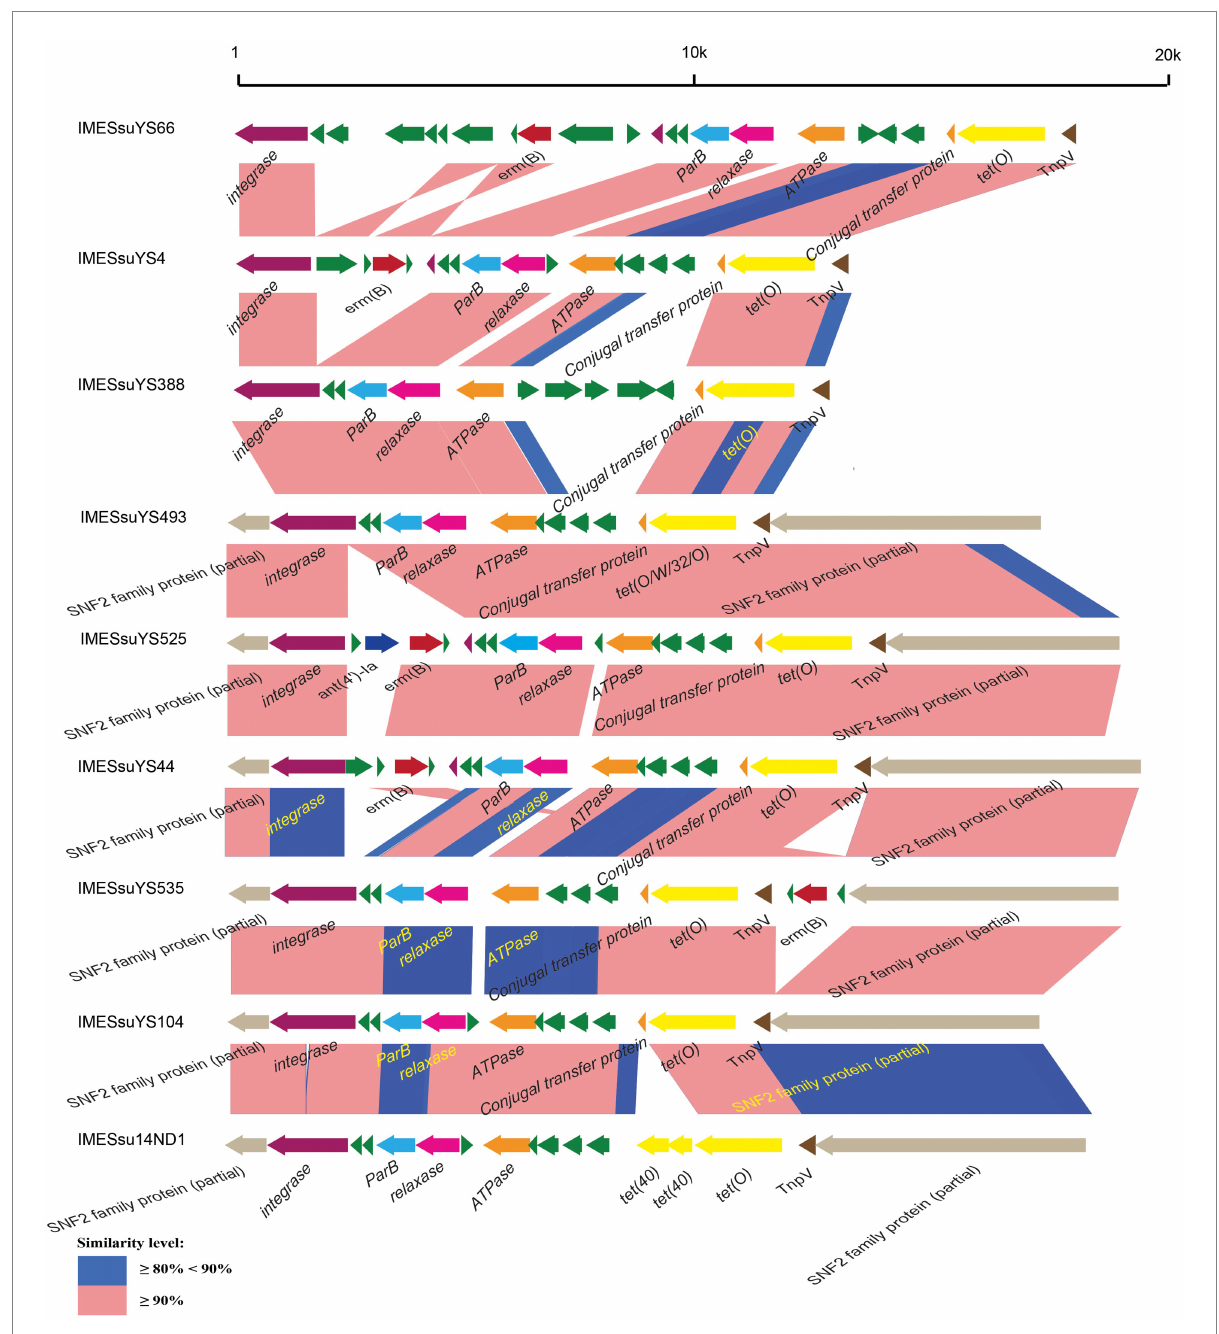
FIGURE 1 Schematic comparison of representative IMEs. The direction of the arrow indicates the direction of transcription. Regions of >90 and 80–90% identity are marked by pink and blue shading, respectively. The AR genes, integrase genes, ParB genes, relaxase genes, ATPase genes, conjugal transfer genes, TnpV genes, snf2 genes are indicated by different